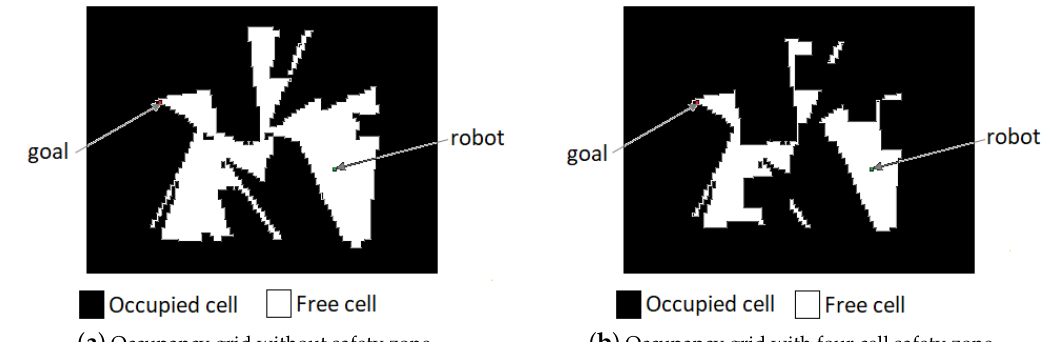
Figure 7. Comparison of occupancy grid without/with safety zone.